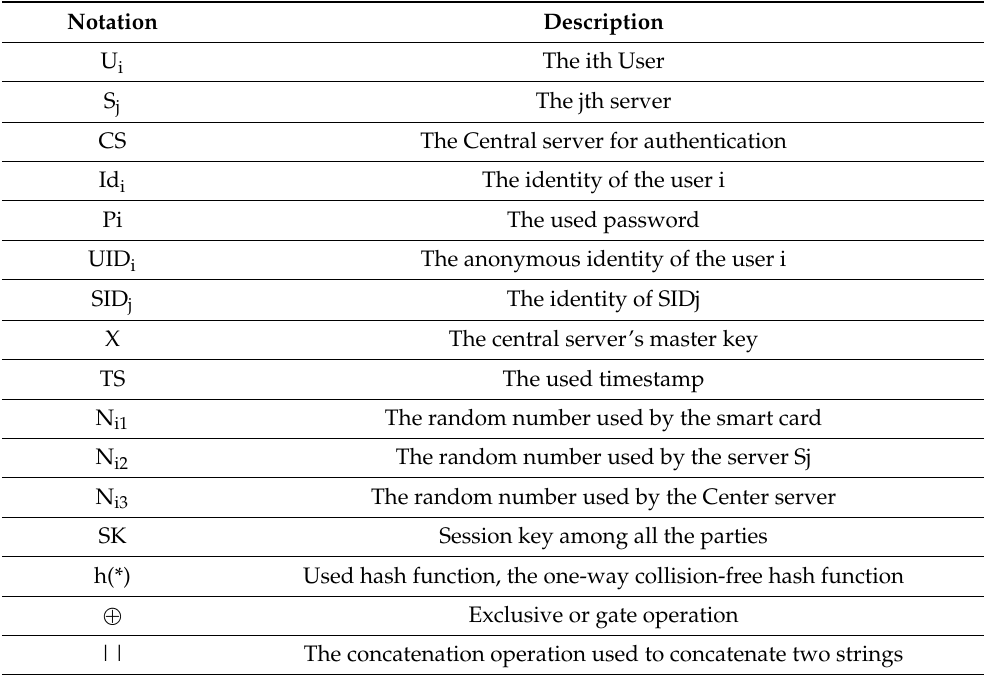
Table 1. Various notation used in